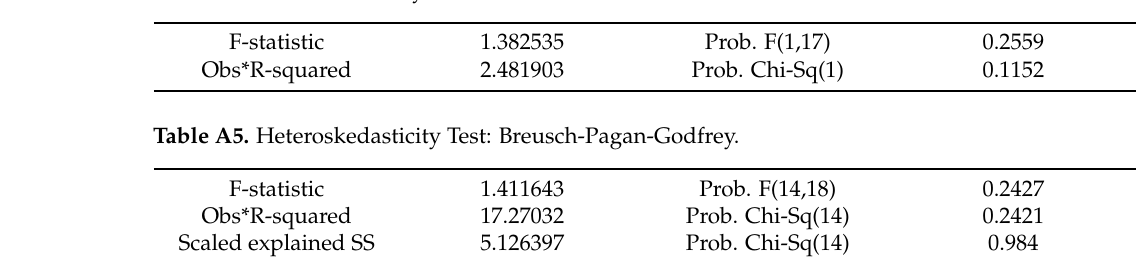
Table A4. Breusch-Godfrey Serial Correlation LM Test.